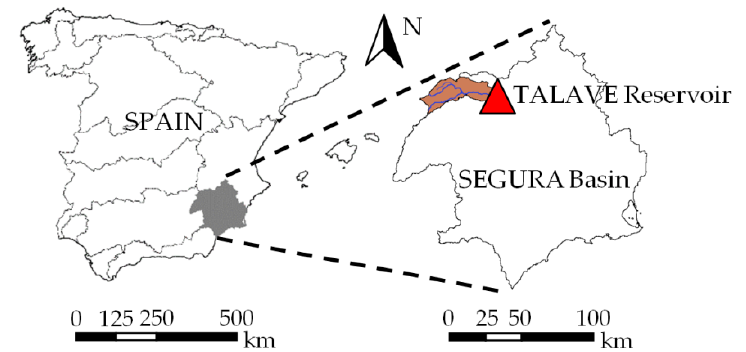
Figure 1. Location of Talave dam in the Segura River Basin.